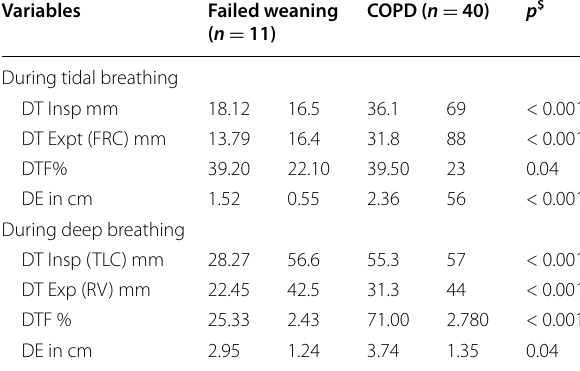
Numerical data is represented as mean and SD , N number, SD standard deviation, $ independent t -test, p is considered significant if < 0.05